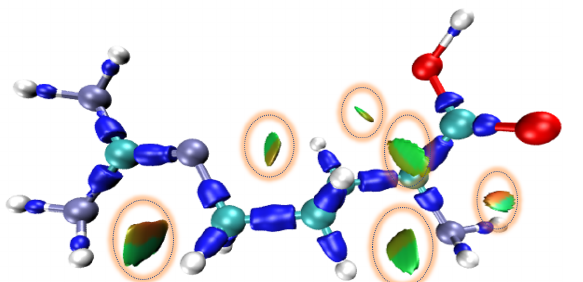
Figure 8. Isosurface map of L-arginine obtained by the VMD, where Carbon, Hydrogen, Oxygen, and Nitrogen atoms are colored in cyan, white grey, red, and slateblue, respectively, and the long dark blue bar indicates the chemical bond. The coloring of this figure is consistent with that of Figure 4.